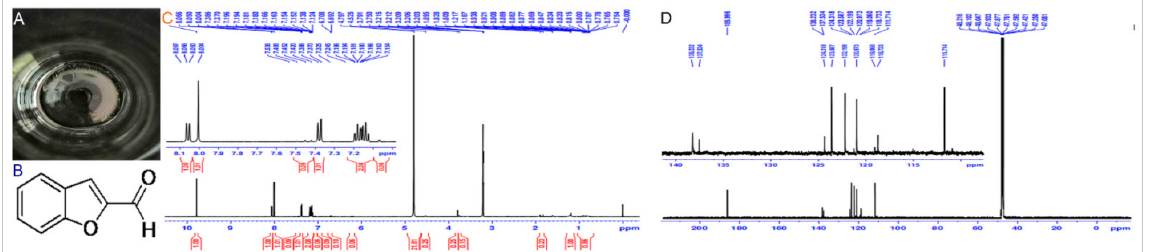
Figure 3. Morphology and structure identification of BFC. Note: ( A ) physical state; ( B ) structural formula; ( C ) 1 H-NMR diagram of BFC (500 MHz, MeOD); ( D ) 13 C-NMR of BFC (126 MHz, MeOD).